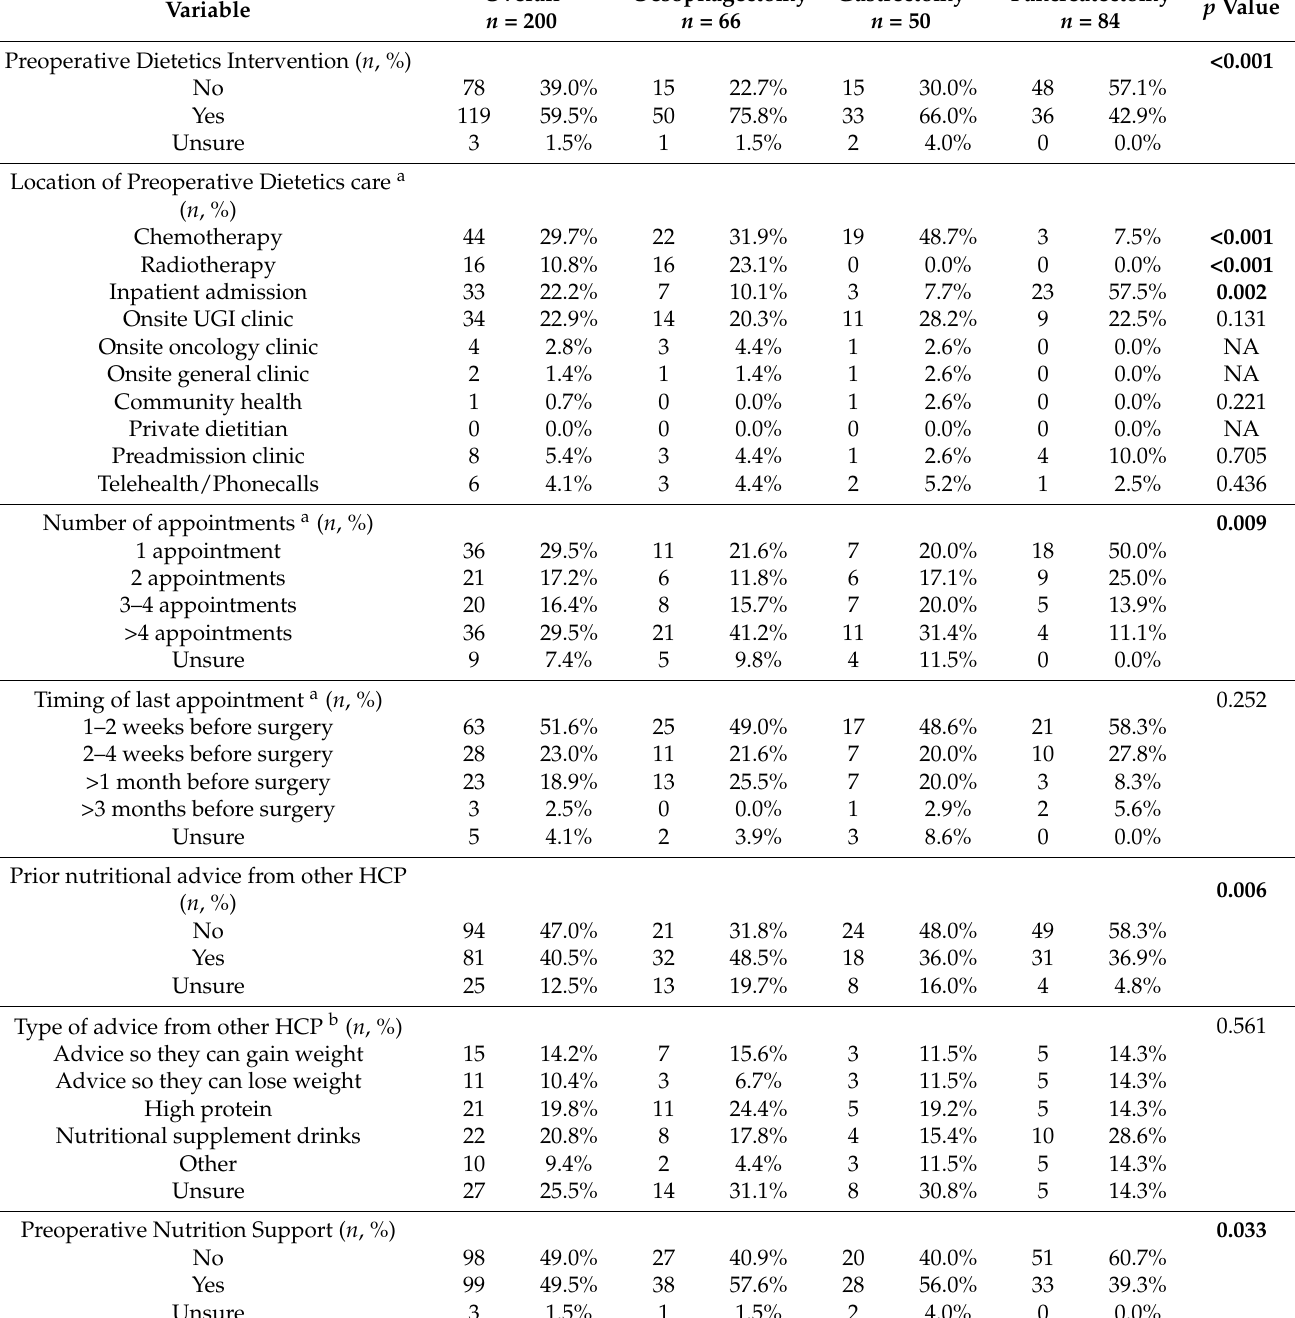
Table 2. Dietetics and nutritional intervention by surgery